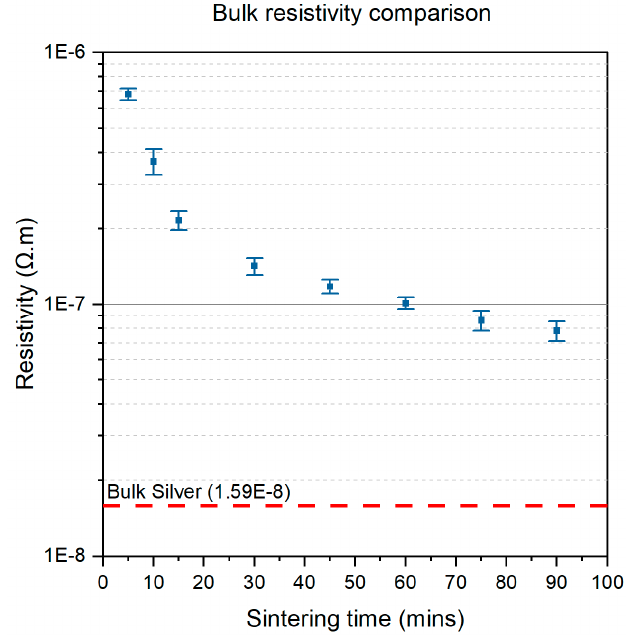
Figure 4. Conductivity improvement of the silver NPs when sintered at 160 °C up to 90 min.